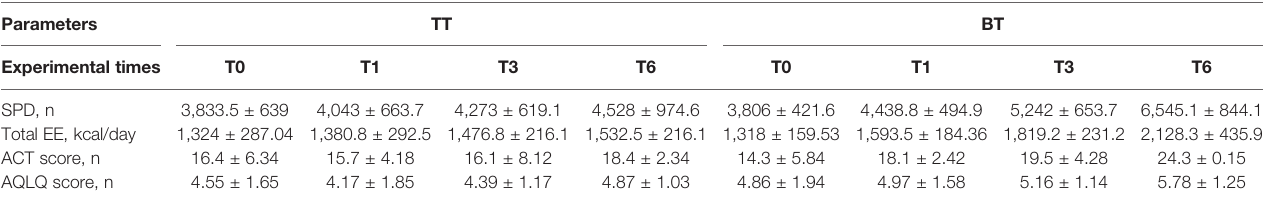
TABLE 2 | Physical activity, asthma control test (ACT), and asthma quality of life questionnaire (AQLQ) scores at T0, T1, T3, and T6 in biologic therapy (BT) and traditional treatment (TT) groups. Parameters TT Experimental times